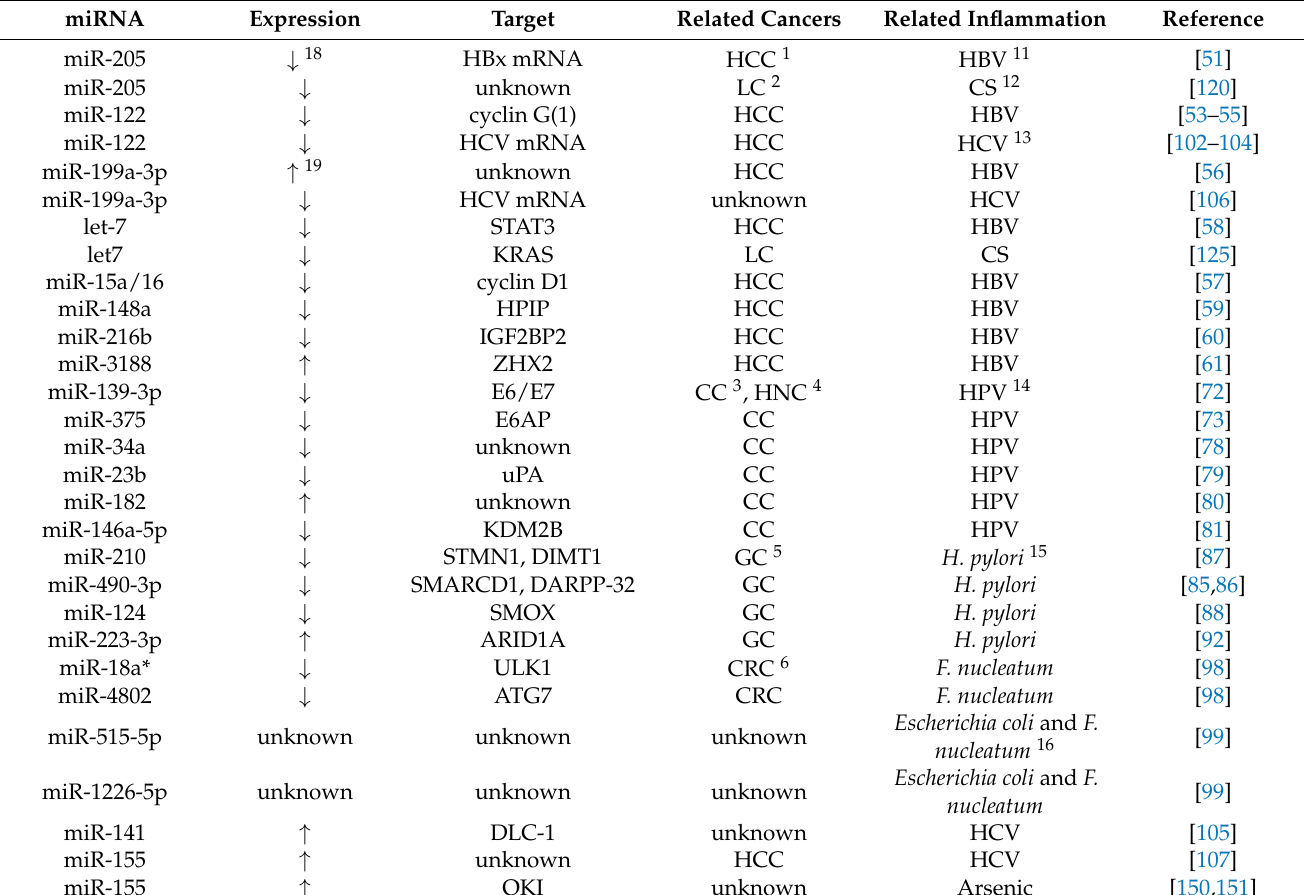
Table 1. Overview of miRNAs in cancers regulated by